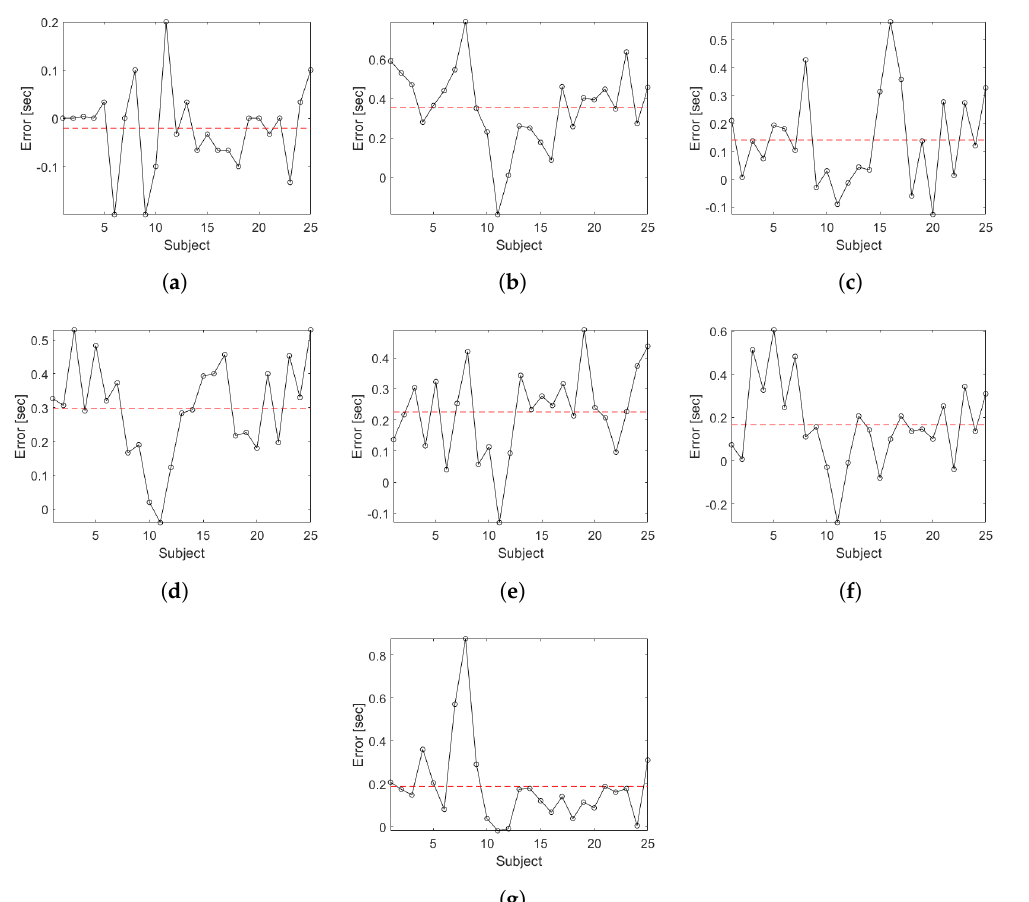
Figure 15. Error plots for the segmentation time for each sub task of the TU & Go test in young subjects. The segmented lines correspond to the mean error. ( a ) end of the standing/start of the first walk; ( b ) end of the first walk/start of the 3-m turn; ( c ) end of the 3-m turn/start of the second walk; ( d ) end of the second walk/start of the pre-sitting turn; ( e ) end of the pre-sitting turn; ( f ) start of the sitting; ( g ) end of the